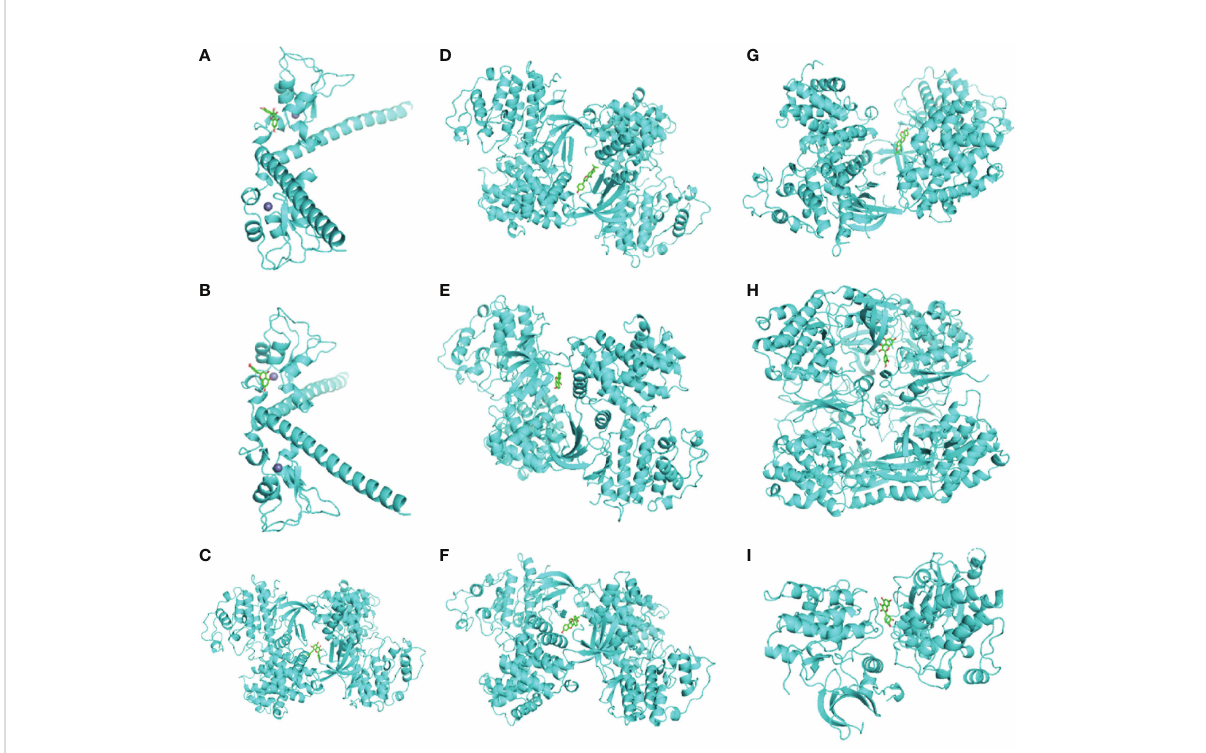
FIGURE 10 (A) BIRC5-quercetin, (B) BIRC5-luteolin, (C) CCNA2-8_Isopentenyl_kaempferol, (D) CCNA2-Wighteone, (E) CCNA2-formononetin, (F) CCNA2- Glyceollin, (G) CCNA2-Phaseolin, (H) CDK1-quercetin, and (I)